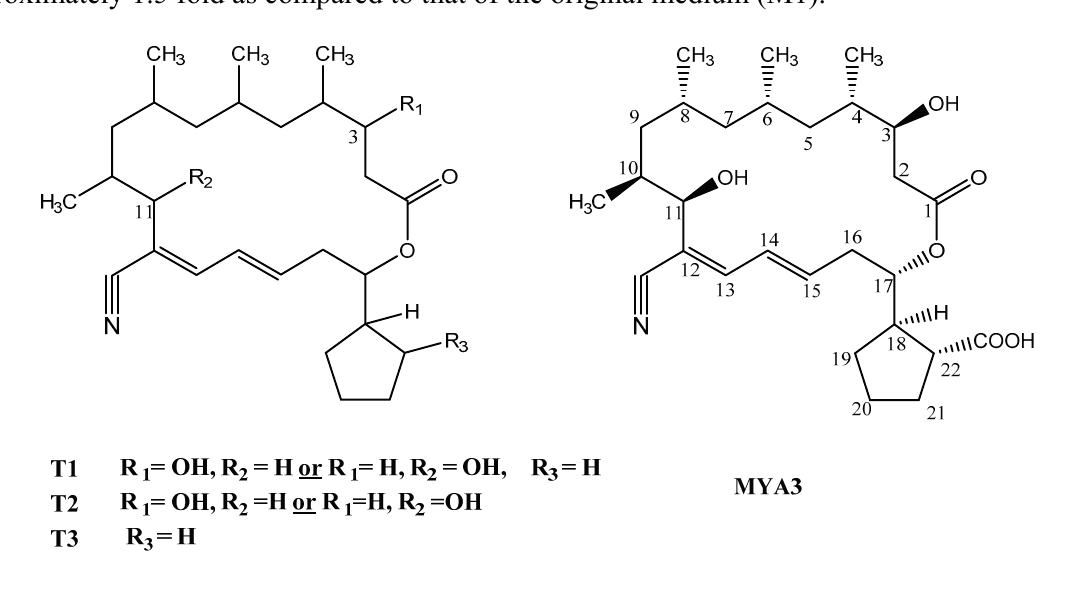
Figure 2. Structure of trepenomycin (MYA-3) and its metabolites